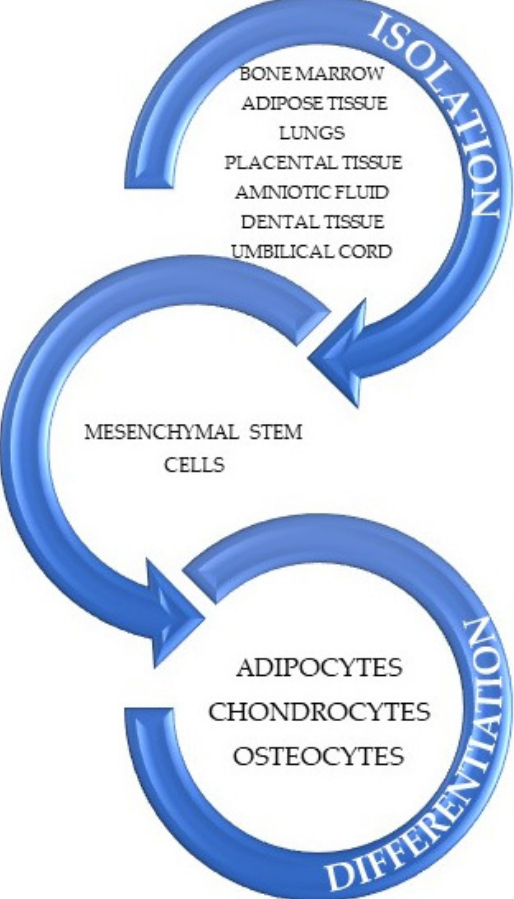
Figure 3. Representation of sources of MSCs and the differentiation in cell lines. Adapted from an open-access source